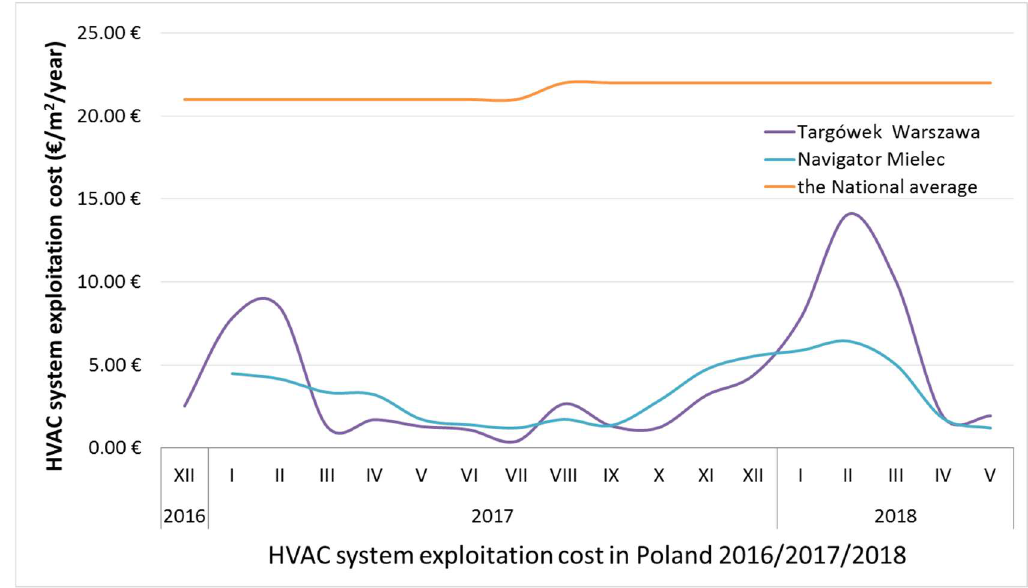
Figure 8. Final energy (FE) consumption result in the period from December 2016 to July 2018 (system exploitation cost, €/m 2 /year). A comparison of a system based on district heating and an alternative system based on electrical energy.